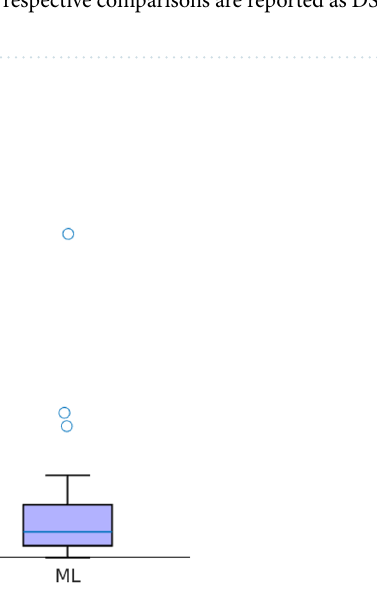
Figure 2. Tumor contours of machine learning and the two raters (red solid curves). The contours are superimposed on the VIBE image. From left to right: Original VIBE image, contours of ML, rater 1 (R1) and rater 2 (R2). Dice similarity coefficients of the respective comparisons are reported as DSC ML,R1 = 0.96 ,